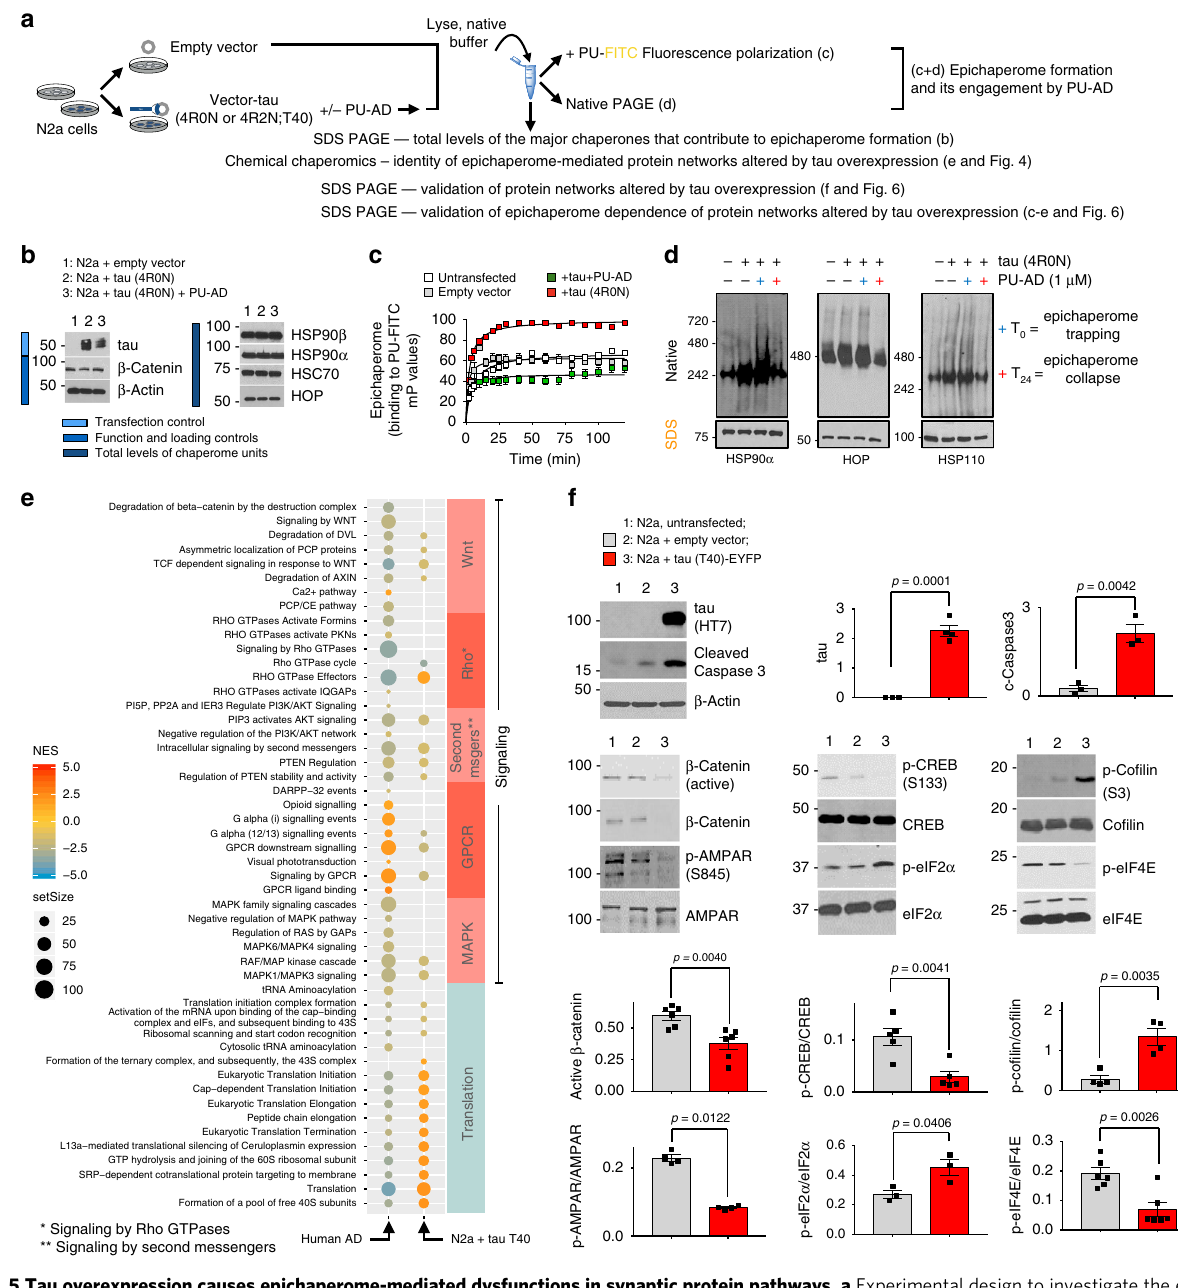
Fig. 5 Tau overexpression causes epichaperome-mediated dysfunctions in synaptic protein pathways. a Experimental design to investigate the effect of tau overexpression on the epichaperome network and on synaptic protein pathways. b Western blot, c fl uorescence polarization and d native PAGE analyses con fi rm epichaperome network formation upon human tau introduction into N2a cells. b , d Gels are representative of three independent experiments. c Error bars show mean ± SEM, n = 3 independent experiments performed in triplicate. e Dot plot shows the identity of stress-speci fi c dysfunctions in synaptic protein pathways that are mediated by the epichaperome, as identi fi ed by chaperomics, in human AD versus ND brains and in N2a cells expressing the T40 tau isoform versus empty vector. Select Reactome pathways with focus on those important for synaptic fi tness are shown. Normalized enrichment score (NES) is indicated by node colour. The number of DC proteins (setSize) are indicated by the size of the nodes. Details on DC analyses and GSEA are described in Methods. f Western blot analyses validate the identity of pathways altered by tau through an epichaperome-mediated mechanism. Chosen for validation are: β -catenin degradation related to impaired axon-dendrite contact during synapse (see Wnt pathway); defective actin remodelling which we monitor via p-co fi lin (see RhoGTPase and Galpha(12/13) signalling); defects in signalling networks that converge on CREB phosphorylation and activation of its transcriptional activity (see signalling by second messengers and MAPK pathways) and defective protein synthesis (see protein translation pathways). These pathway dysregulations converge on a defective LTP; phosphorylation of the GluA1 subunit of AMPAR on S845 is a critical step in LTP, and we use it as a biochemical LTP surrogate. Graph, mean ± SEM, unpaired two-tailed t -test, n = 3 – 6, as indicated. Representative blots are also shown. Source data are provided as a Source Data fi